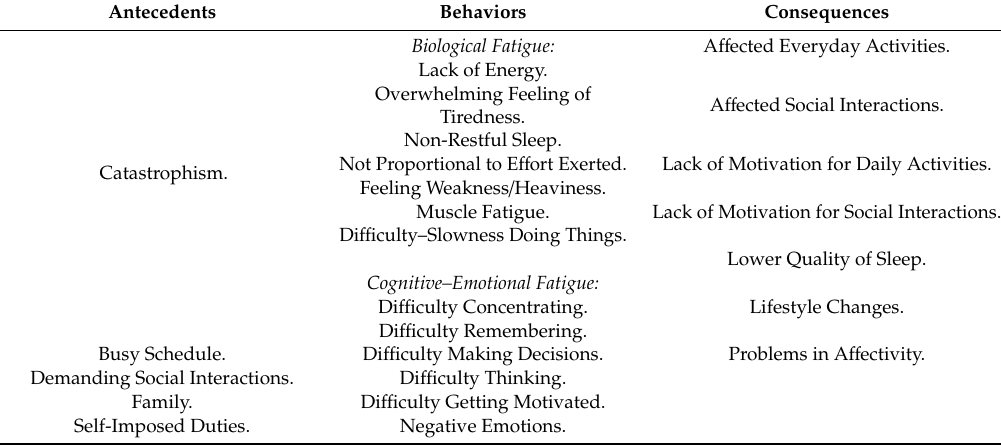
Table 3. The ABC (Antecedents–Behaviors–Consequences) proposed model of fatigue in fibromyalgia in the di ff erent situations of the